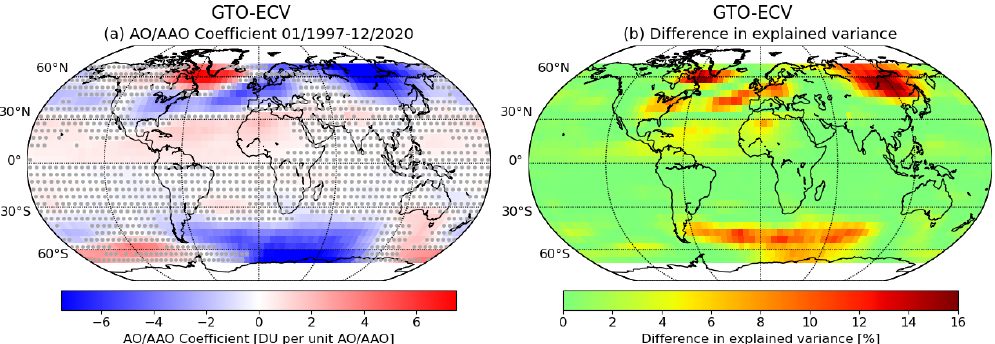
Figure 2. (a) MLR fit coefficient for the additional explanatory variables AO (applied in Northern Hemisphere) and AAO (applied in the Southern Hemisphere) in Dobson units (DU) per unit (A)AO index. (b) Difference in explained variance (in %) between the MLR including the A(AO) proxy and the MLR without the additional proxy.